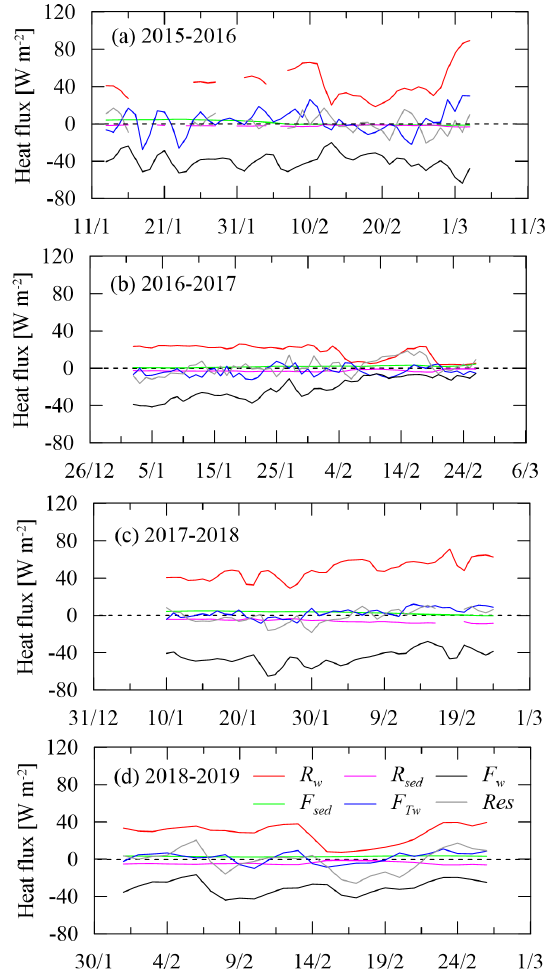
Figure 8. Heat budget of the under-ice water ( R w : transmitted solar radiation; R sed : absorbed solar radiation by sediment; F w : water- to-ice heat flux; F sed : heat released from sediment; F Tw : sensible heat caused by water heat content change; Res: residual of heat bal- ancing, which is supposed to be zero when all heat fluxes balance